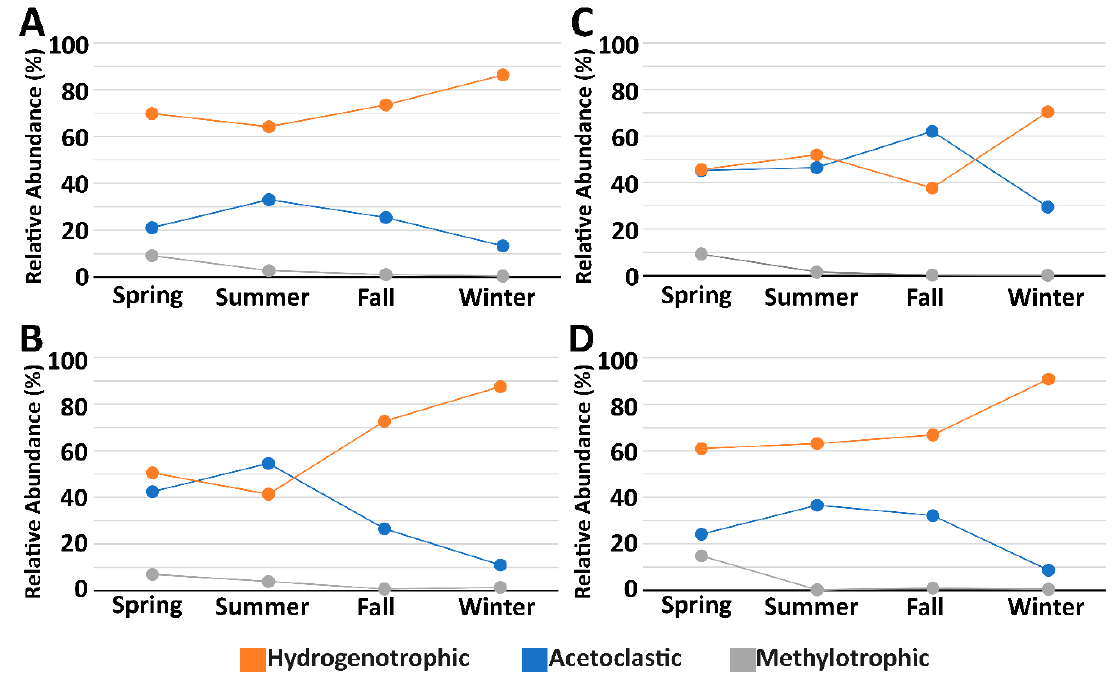
Figure 7. Relative abundance of classified operational taxonomic units (OTUs) potentially involved in methanogenic pathways. ( A ) Open Lagoon; ( B ) Open House; ( C ) Covered Lagoon; ( D ) Covered House.